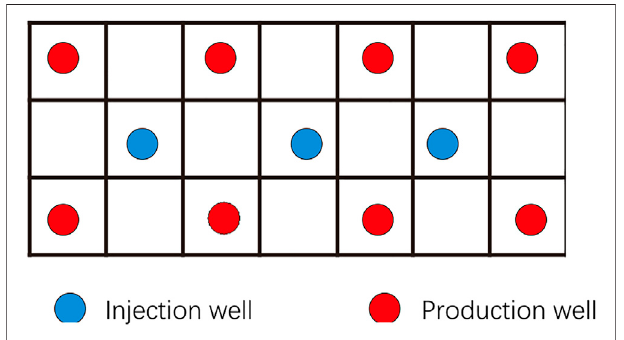
FIGURE 2 | Illustration of well placement in evaluating the productivity potential by using the numerical simulation method.